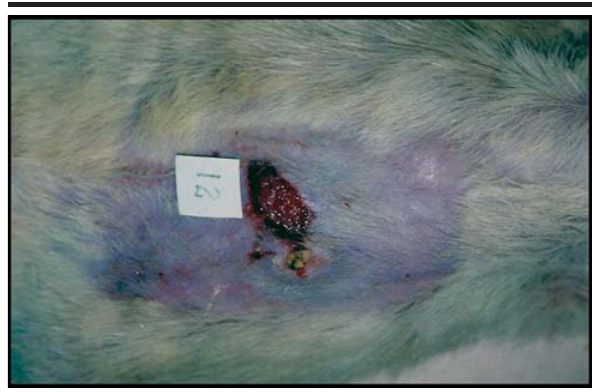
FIGURE 2 - Animal of cohort E-A with abscess and great FIGURE 3 - Posterior sight of abdominal wall of animal in necrosis of the skin cohort E-B, where adhesion to all quadrants can be seen TABLE 1 - Percentage of adhesions in each quadrant and their quality in cohorts C-A, E-A and